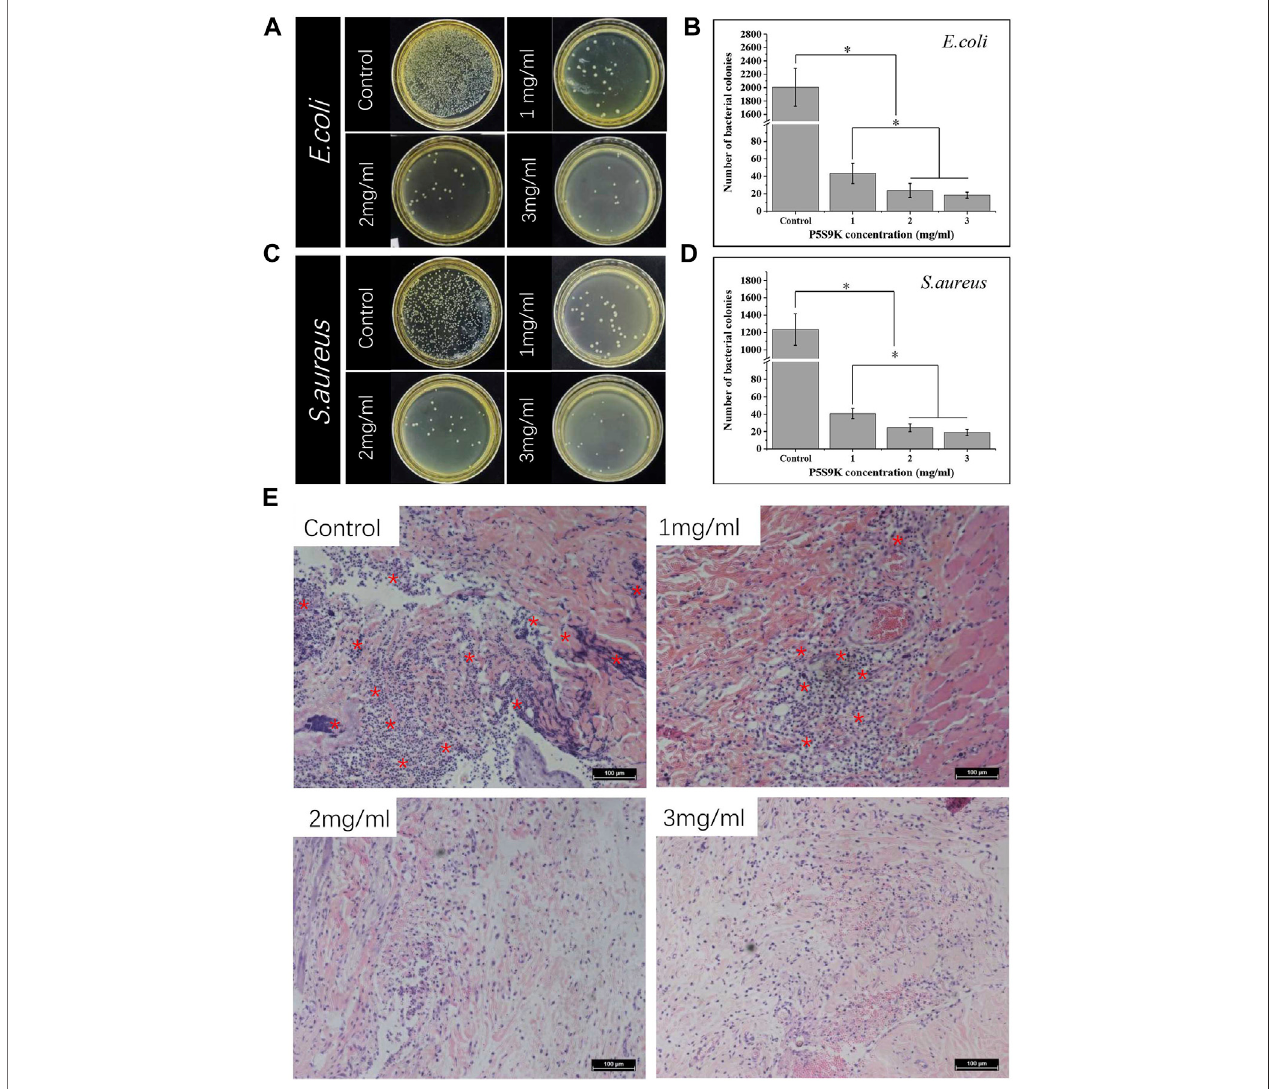
FIGURE3| Photosandnumbersofbacterialcoloniesformedby E.coli (A,B) and S.aureus (C,D) treatedwithdifferentmembranes(P5S9K:1,2,3 mg/mlandCS: Control) (E) H&E staining of different membranes embedded in rat infected tissue. Red asterisks indicate areas of in fl ammatory cell in fi ltration, n = 3, p < 0.05.